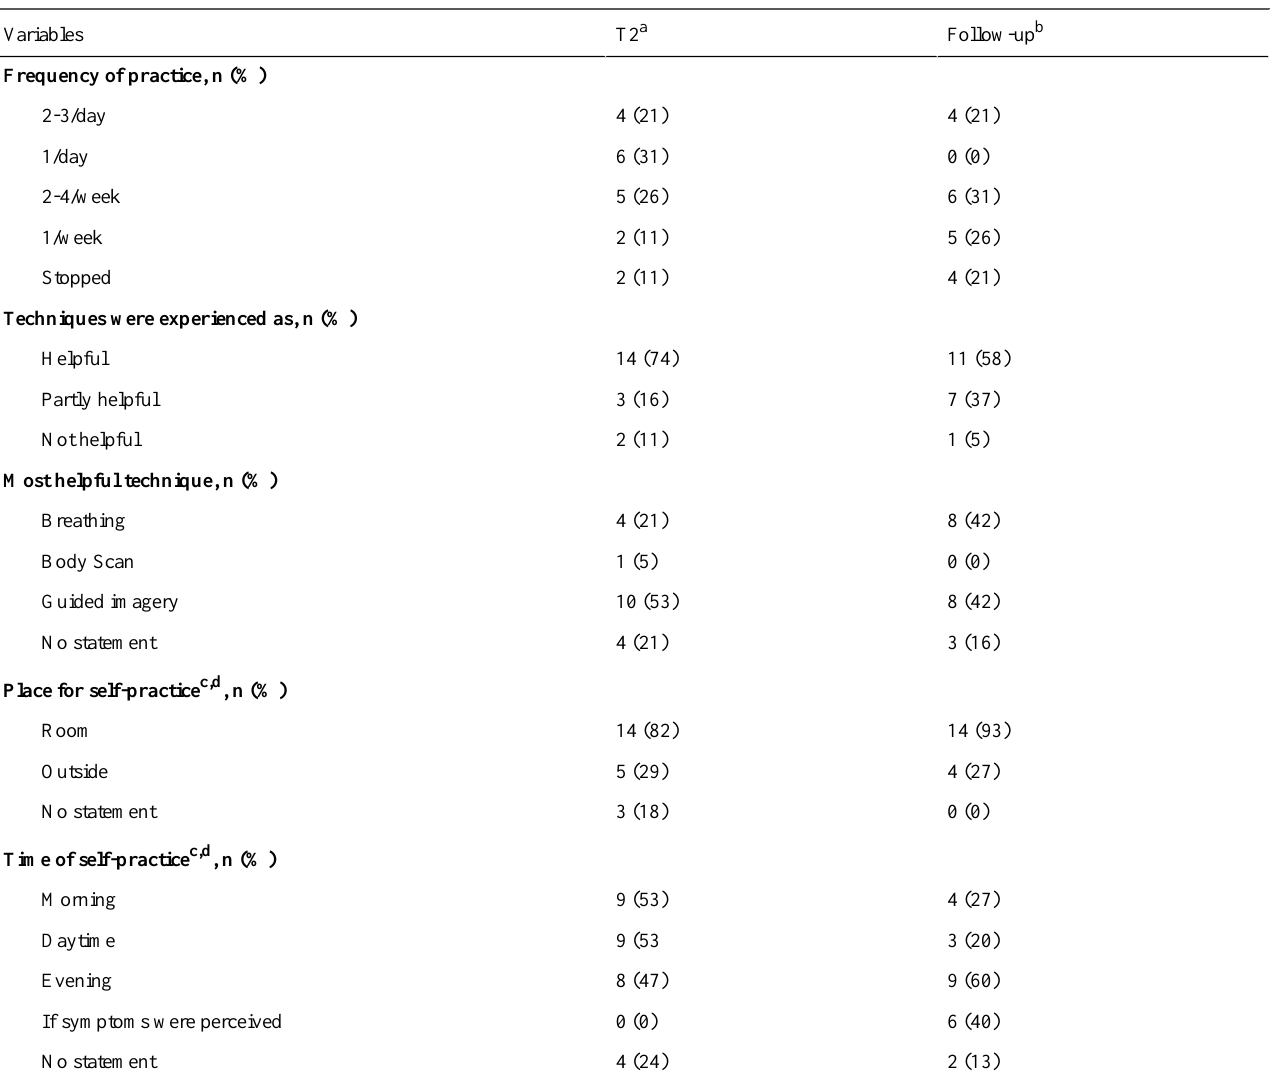
Table 2. Statements regarding the self-practice behavior of stabilizing and guided imagery